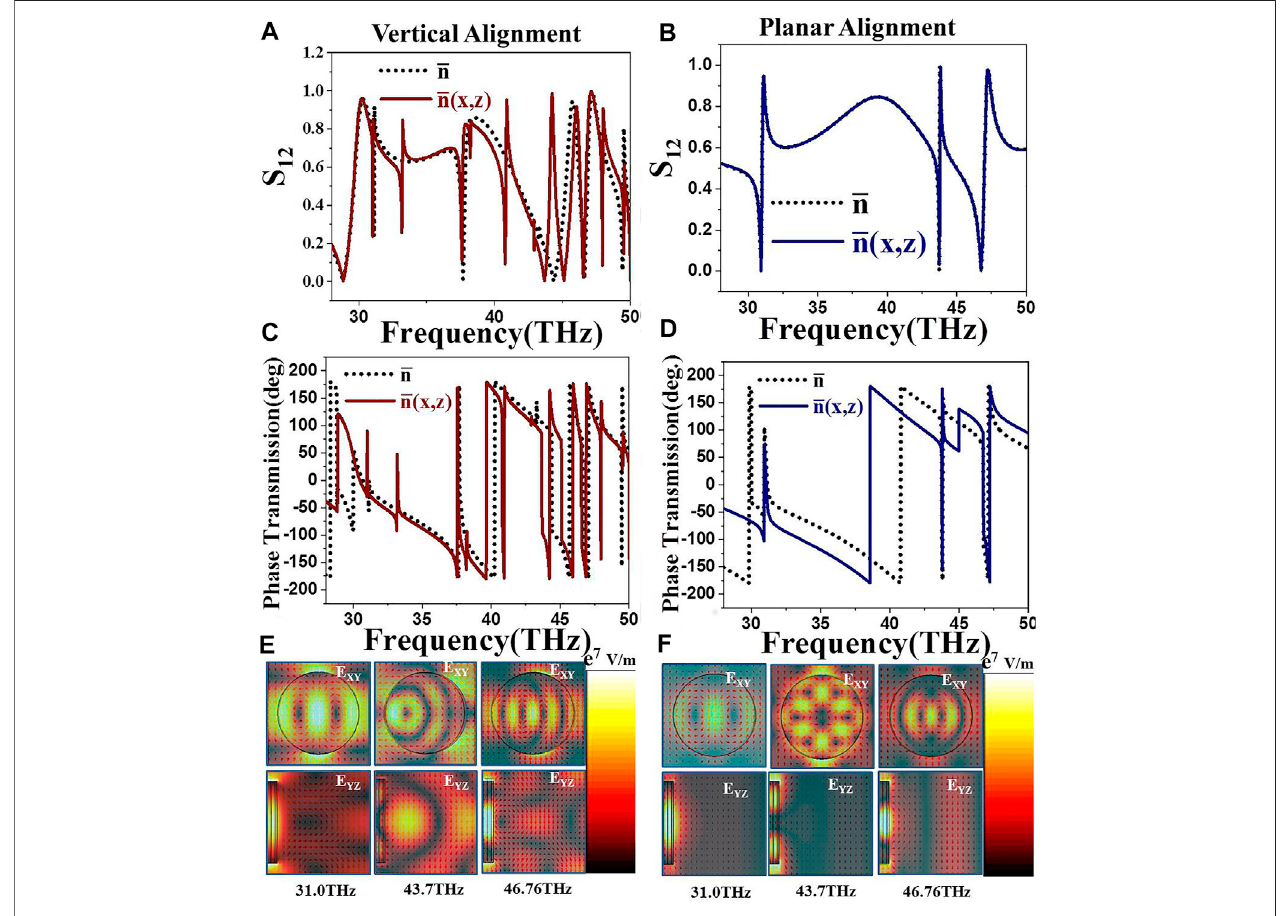
FIGURE 3 | Electromagnetic response of DFLC with cylindrical microstructures: (A,B) . S 12 parameters for vertical (ON state, f L ) and planar aligned con fi guration (OFF state, f H ) of DFLC cell respectively. (C,D) . Phase of transmitted light at f L and f H respectively. (E,F) . Near- fi eld pro fi les of electric fi eld components in XY plane (top) and scattered electric fi eld pro fi les in YZ plane (bottom) at f L and f H